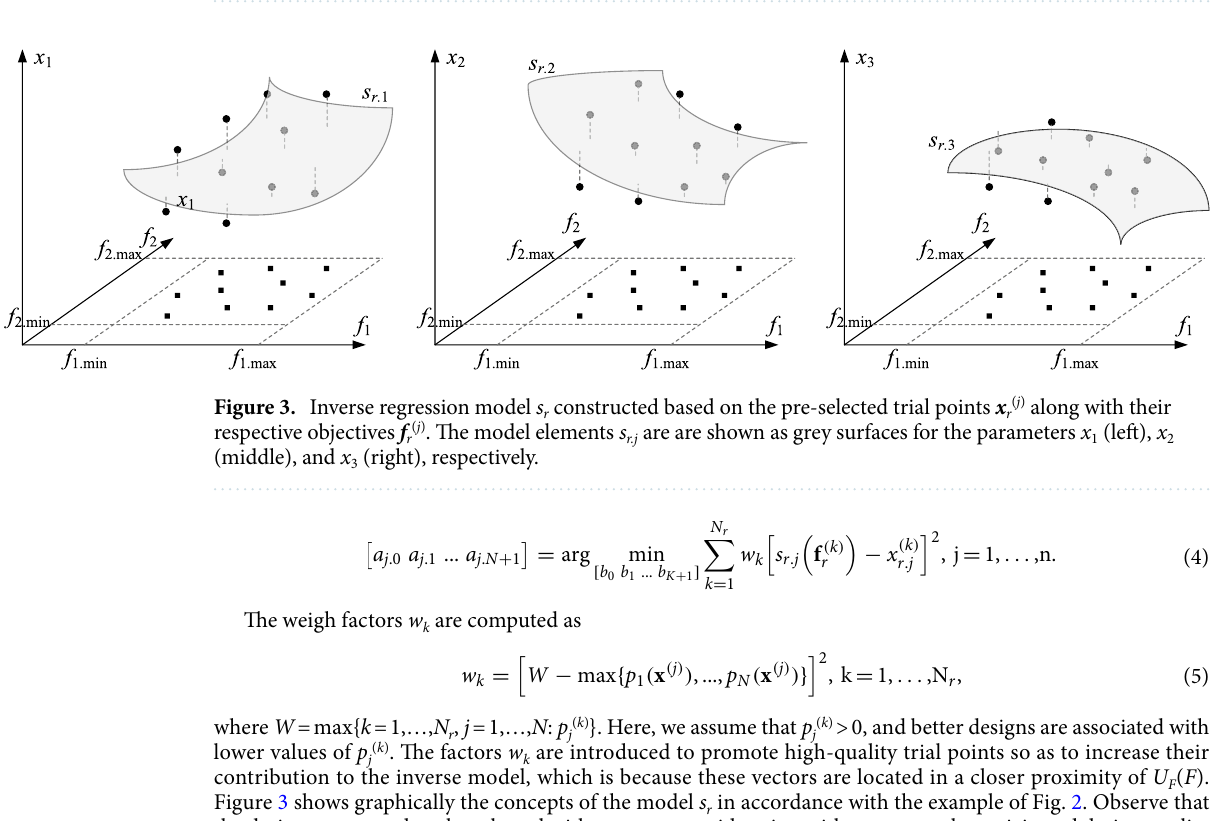
Figure 2. Procedure of the random trial point rendition for an exemplary dual-band antenna (the objective and parameter space are two- and three-dimensional, respectively). The random designs whose resonant frequencies reside within the required confines of the objective space are retained, the remaining ones are discarded. The inverse regression model s